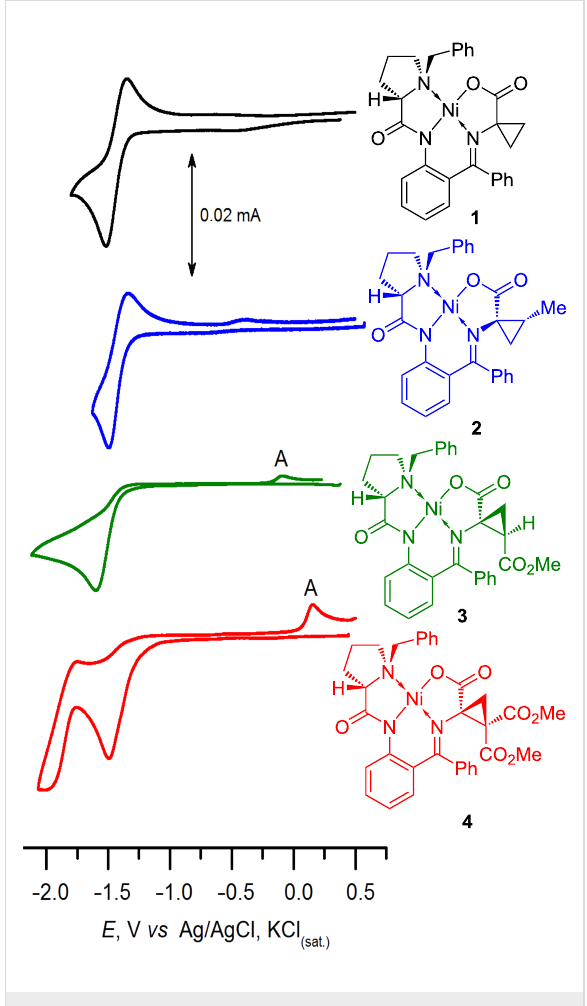
Figure 1: Cyclic voltammograms obtained for complexes 1 (black), 2 (blue), 3 (green), 4 (red) (MeCN, 0.05 M Bu 4 NBF 4 , 100 mV/s, Pt).